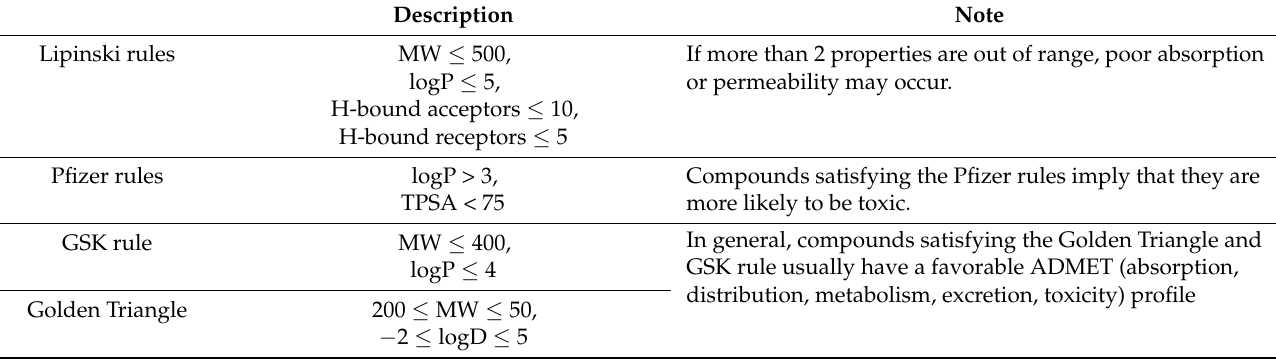
Table 5. Details information of drug-likeness